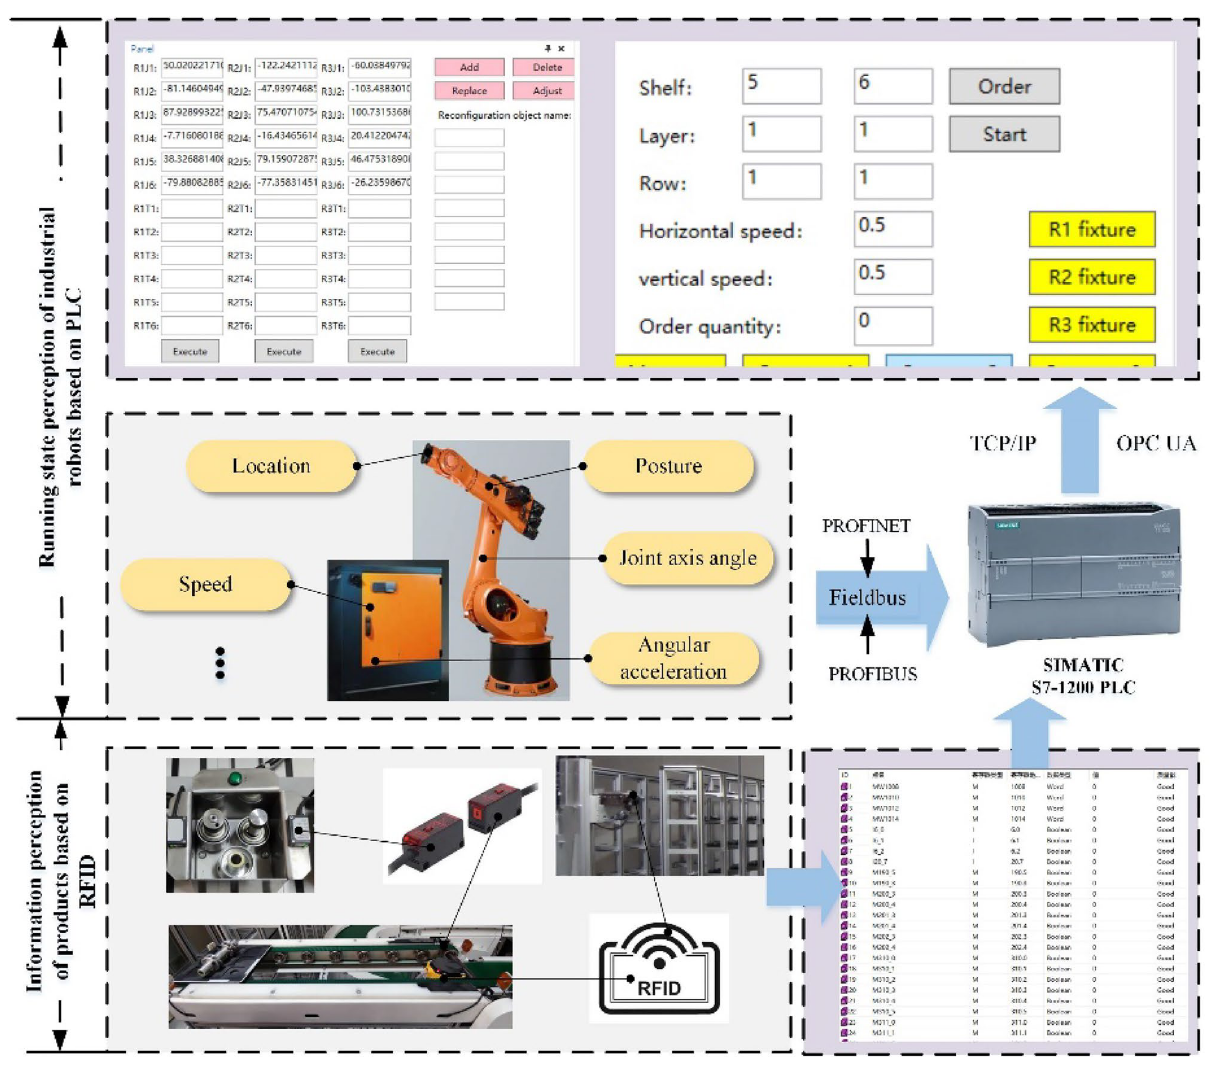
Figure 2. Status perception of PE based on PLC and